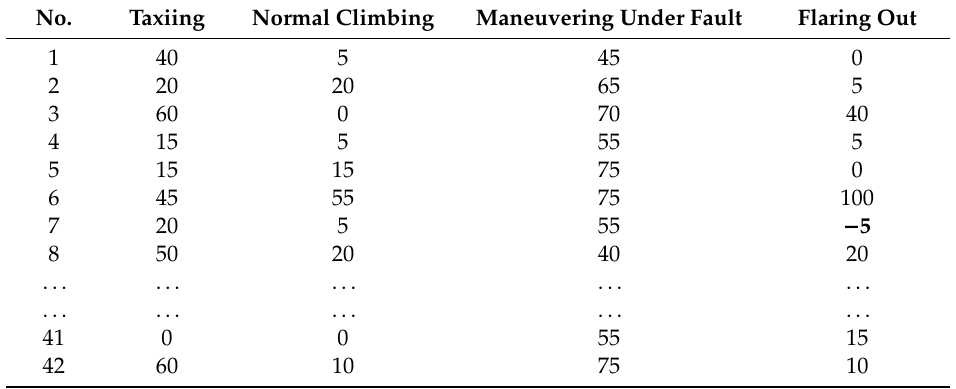
Table 10. Workload prediction results in di ff erent flight phases after unification with NASA-TLX.